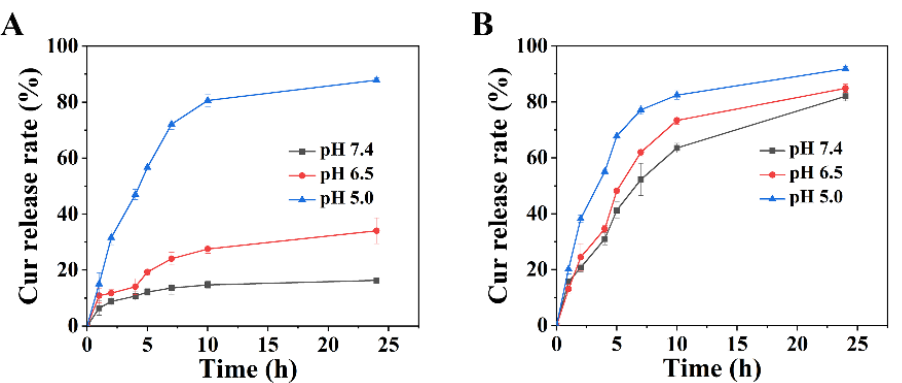
Figure 2. The release rate of Cur of ( A ) AHMSN@GA@PEI@Cur (The Cur release rates of AHMSN@GA@PEI@Cur at pH 7.4, pH 6.5, pH 5.0 are 16.39%, 34.04%, 87.88% at 24 h) and ( B ) AHMSN@Cur under different pH conditions.